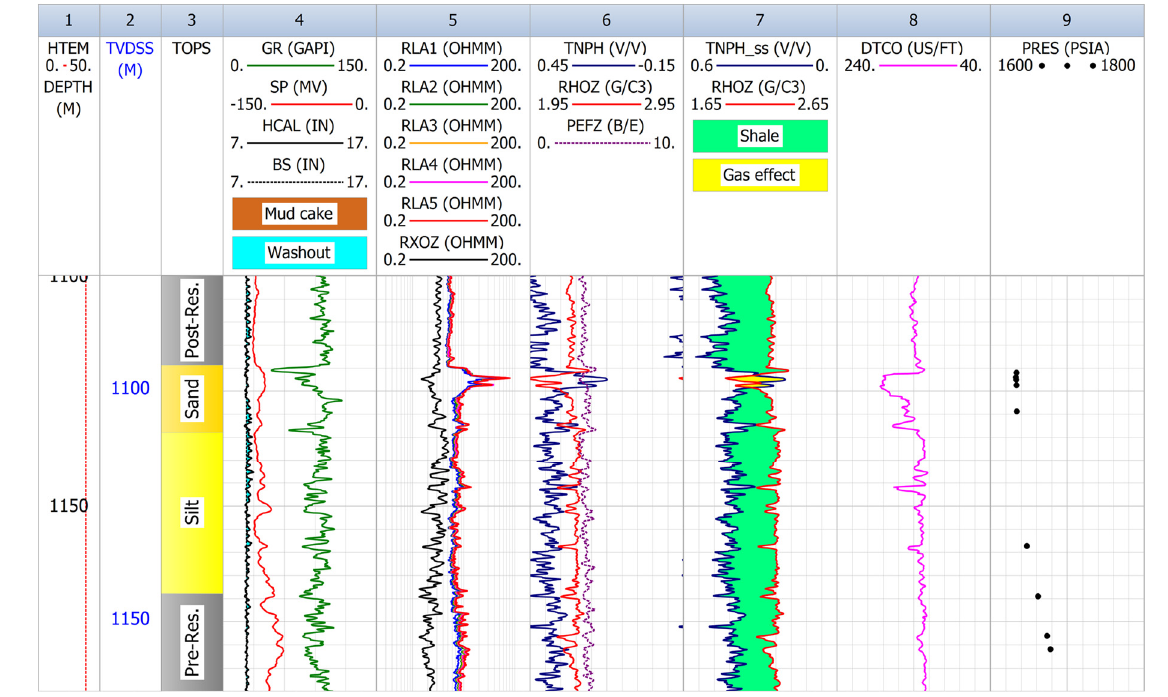
4. Figure 4. Example of wireline geophysical logs recorded in an exploration well (B-4) from the Early Pliocene gas field “B” (adapted from